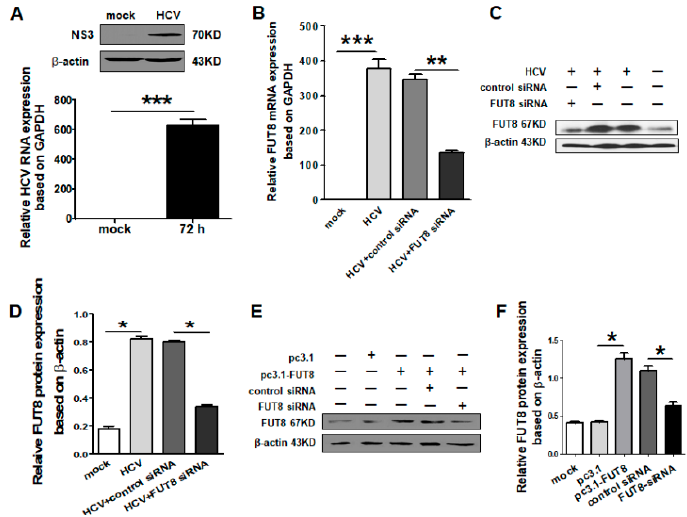
Figure 1. FUT8-specific siRNA and recombinant expression vector were designed and verified. ( A ) qRT-PCR and Western blotting analysis were used to detect the relative hepatitis C virus (HCV) RNA expression and non-structural protein 3 (NS3) protein level 72 h post HCV infection in Huh7.5.1 cells. Mock: only Huh7.5.1 cells. The specificity of the FUT8 siRNA was confirmed by RT-PCR ( B ) and Western blot ( C ). Statistical analyses of ( C ) are listed in ( D ). ( E ) Overexpression of FUT8 was confirmed by Western blot after transfection with FUT8 plasmid (pcDNA3.1-FUT8, named pc3.1-FU8). Statistical analyses of ( E ) are also listed in ( F ).